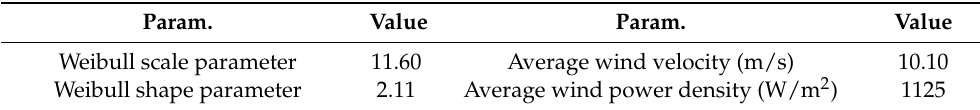
* Nomenclature in Table 1: P rated is the wind turbine rated power, B is the number of blades, D rotor is the rotor diameter, R hub is the hub radius, γ is the rotor cone angle, T is the tilt angle, V rated is the rated wind speed, Ω rated is the rotor rated rotational speed, V in is the cut-in wind speed, and V out is the cut-out wind speed. The DTU 10 MW wind turbine class is IEC Class IA. This study uses the wind resource data in Table 2 to calculate the annual energy production (AEP) of the wind turbine. Table 2. Basic parameters of wind resource at the site. Param. Value Param. Value Weibull scale parameter 11.60 Average wind velocity (m/s) 10.10 Weibull shape parameter 2.11 Average wind power density (W/m 2 )